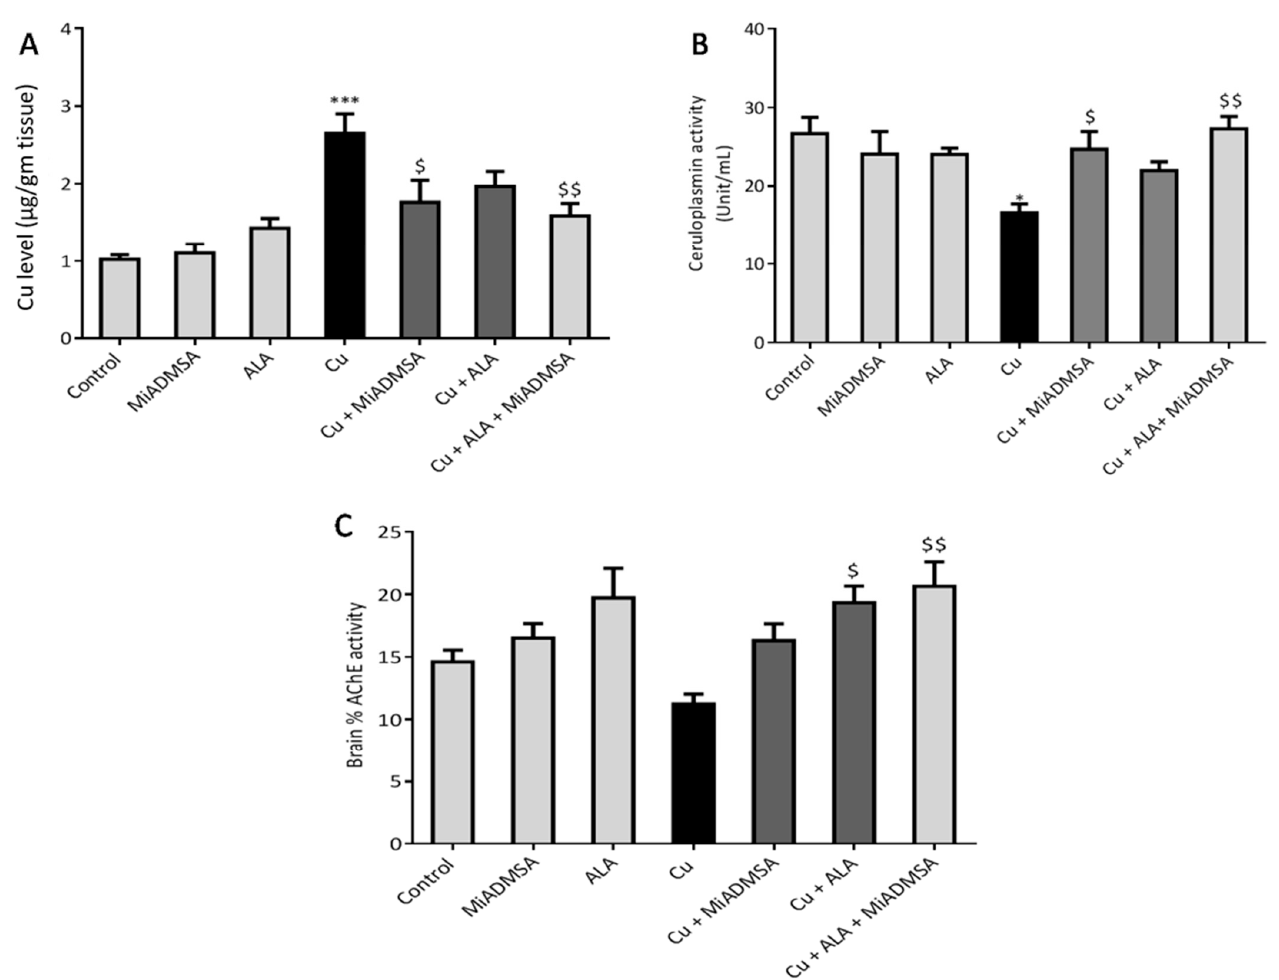
Figure 7. Effect of combination therapy of MiADMSA and ALA on ceruloplasmin level, brain Cu, and AChE levels. ( A ) Brain Cu level; ( B ) Serum ceruloplasmin level; ( C ) Brain AChE levels. All the values are expressed as mean ± S.E.M. ( n = 6) * p < 0.05, *** p < 0.001 vs. control and $ p < 0.05, $$ p < 0.01 vs. Cu.